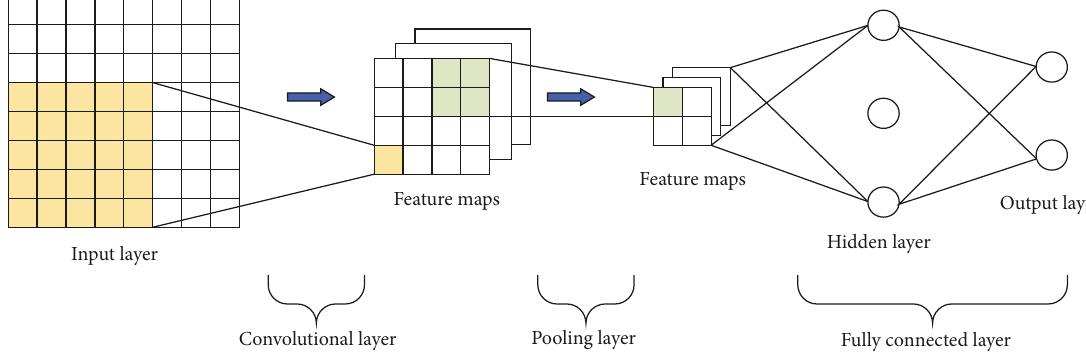
Figure 1: Generic CNN